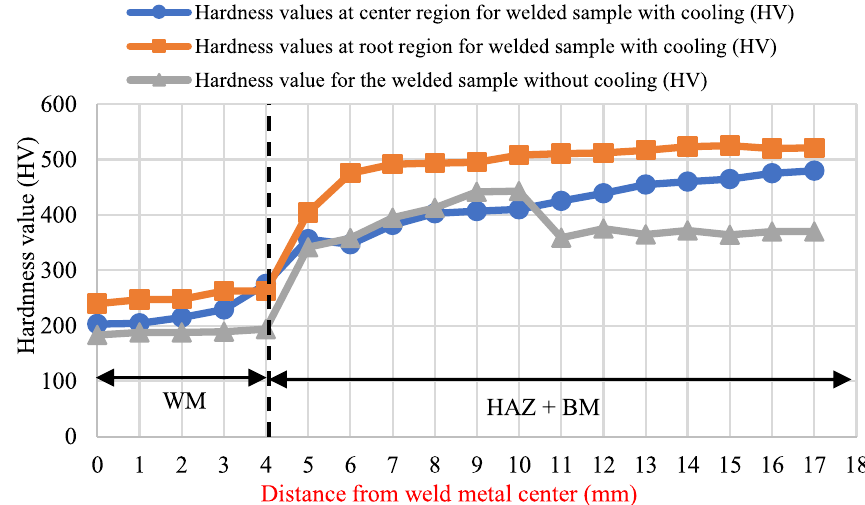
Fig. 16 Hardness distribution in the specimen welded using AWS A5.18 ER 70S-6 and joint a single